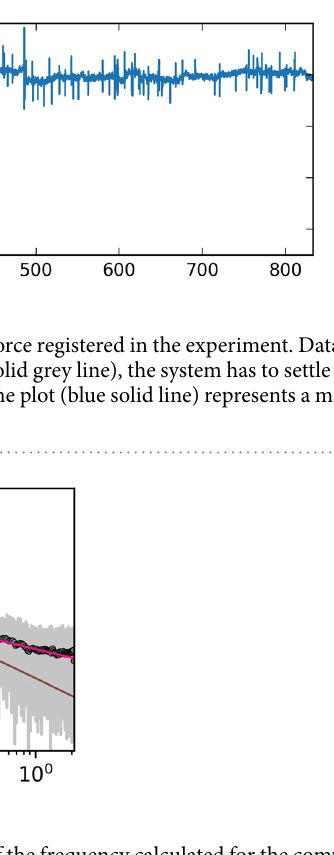
Figure 2. Power spectral density as a function of the frequency calculated for the complete measurement using the ELoPvC. PSD was calculated using the Welch method (grey circles) and shadowed by the results of the discrete Fourier transform (light grey in the background) manifest the 1/ f 2 noise behaviour that is indicated by the solid brown line as well as the 1/ f noise, which is designated by the straight pink line for the minimally stable region of the electromotive